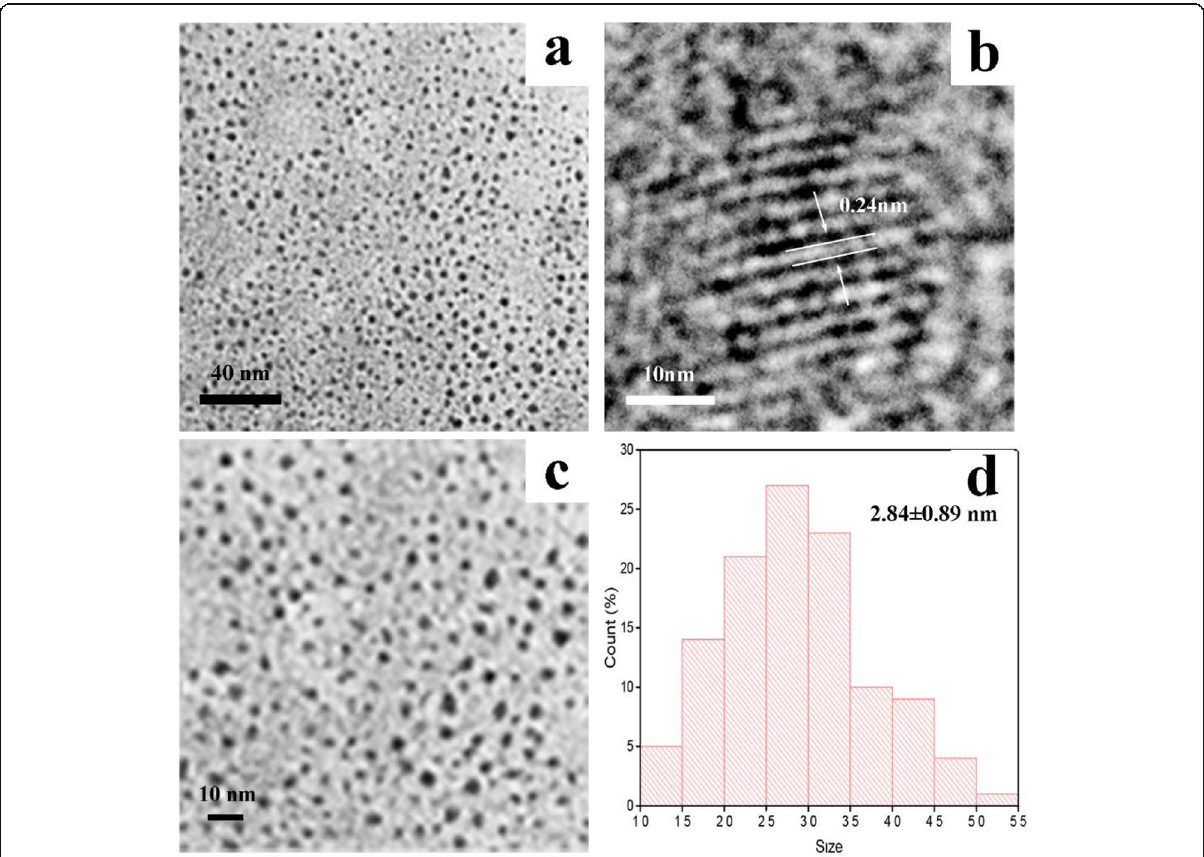
Fig. 2 a and c Transmission electron microscopy (TEM) images of Phellodendri Cortex Carbonisatus carbon dots (PCCC-CDs), b High-resolution TEM image of PCCC-CDs, d Size distribution of